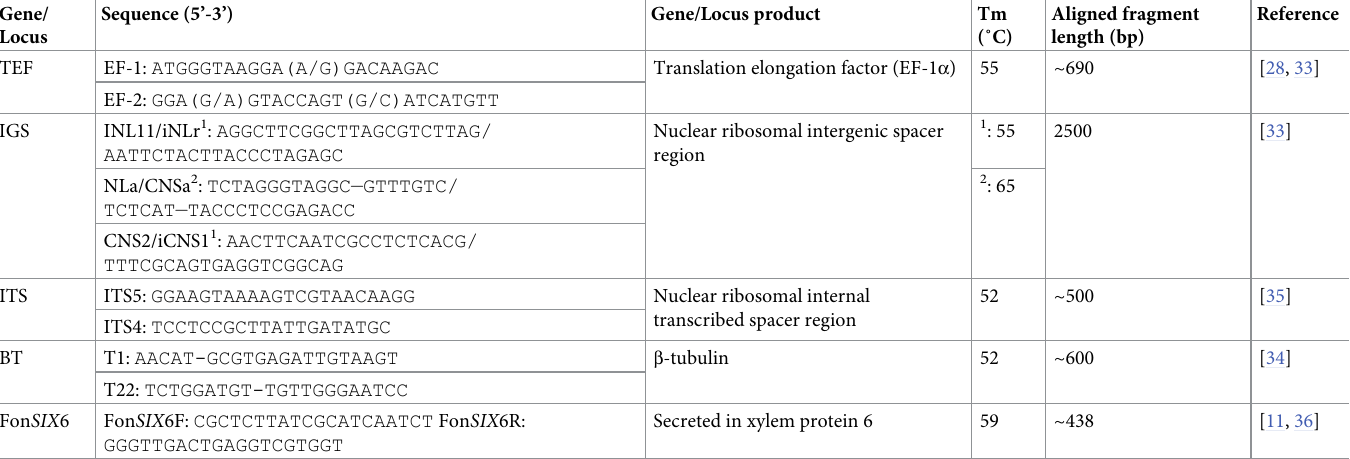
Table 2. The TEF, BT, and FonSix6 genes, and ITS and IGS loci described in this research were amplified using the following primers during polymerase chain reac- tion cycles with the listed thermocycler settings. Gene/